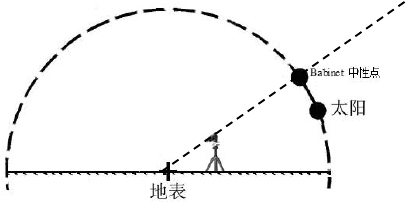
Figure 6. Remote sensing images with small atmospheric impacts (left) and large atmospheric impacts (right) In order to verify the theoretical feasibility of using the neutral point for the separation of ground-air polarization effects(Lee, 1998), a ground verification experiment was designed. The experiment is to polarize the same region at the neutral and non-neutral locations, respectively, and then compare the polarized parameters of the imaging. Figure 7 shows the geometric schematic of the observations for ground experiments, (a) for observations at neutral point, and (b) for observing at non-neutral locations. The degree of polarization on the connection between the surface and the neutral point is zero. The imaging device used in the experiment is Nikon D200 SLR digital camera, placed in front of the camera iodine polarizer, change the polarizer axis and the reference axis angle, respectively, 0°, 60°, 120°three angles of the